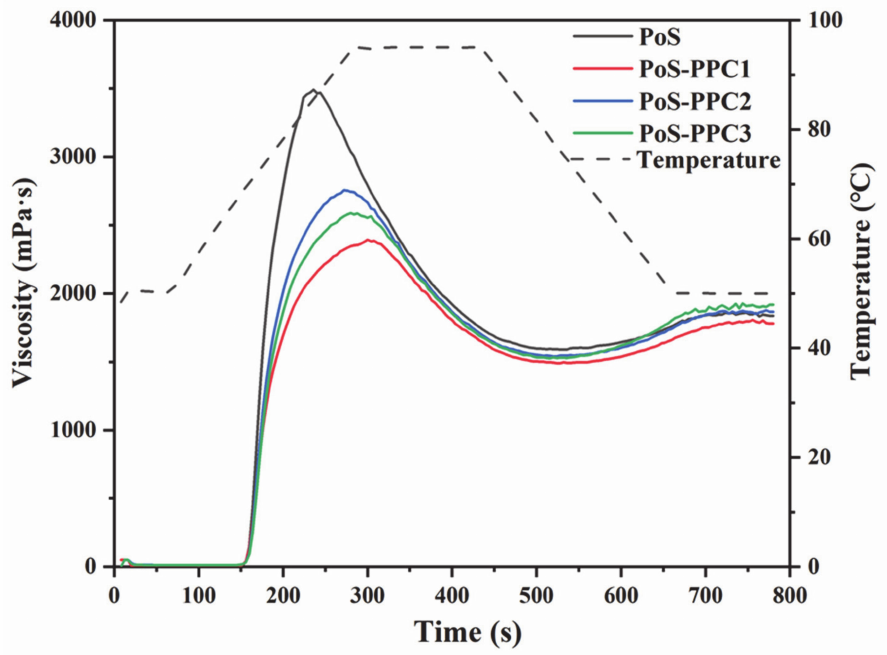
Figure 1. RVA gelatinization curves of native PoS and PoS-PPC pastes. PoS: potato starch; PPC: polymeric